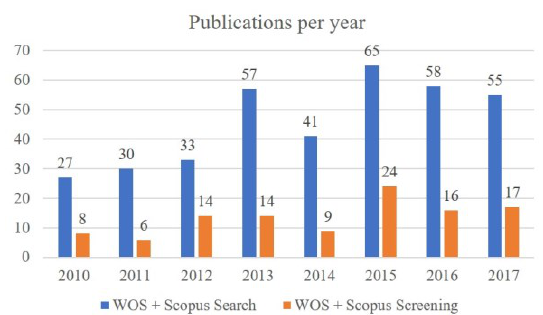
Figure 2: Graph showing comparison of the number of publications per year.